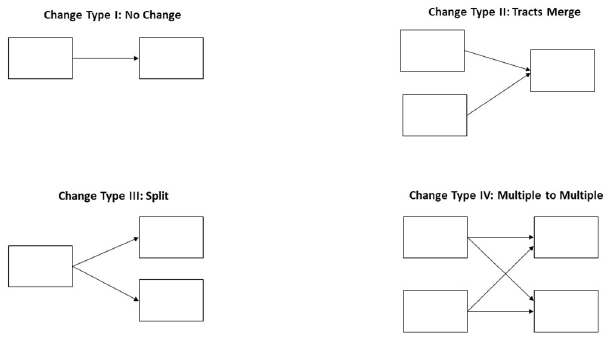
Fig 1. Illustration of change types in the crosswalk